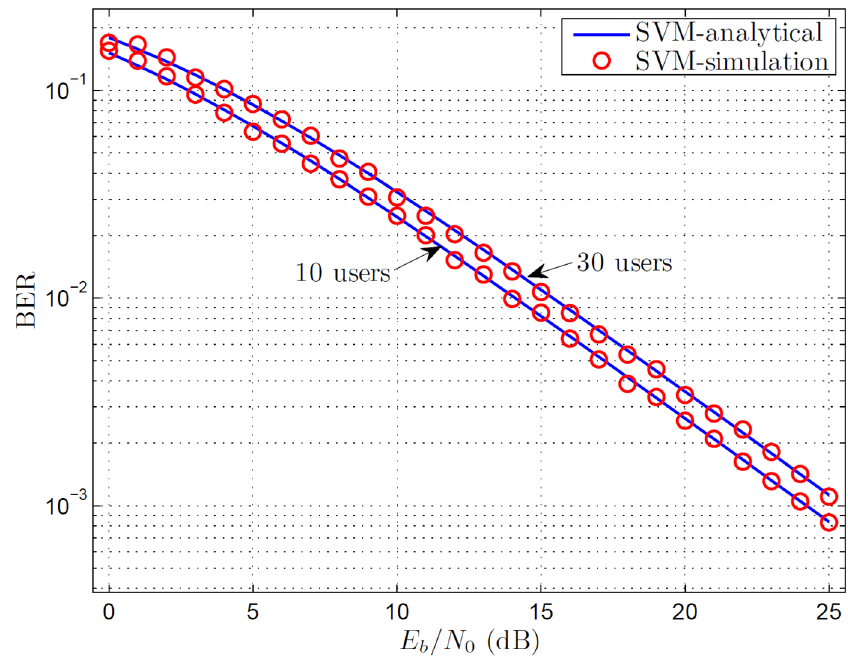
Figure 7 – BER curves obtained by both the theoretical expression in the closed form and the simulation Рис . 7 – Кривые вероятности битовой ошибки (BER), полученные при теоретическом моделировании в закрытом канале Slika 7 – Grafovi verovatno ć e greške bita (BER) dobijeni prema teorijskom izrazu